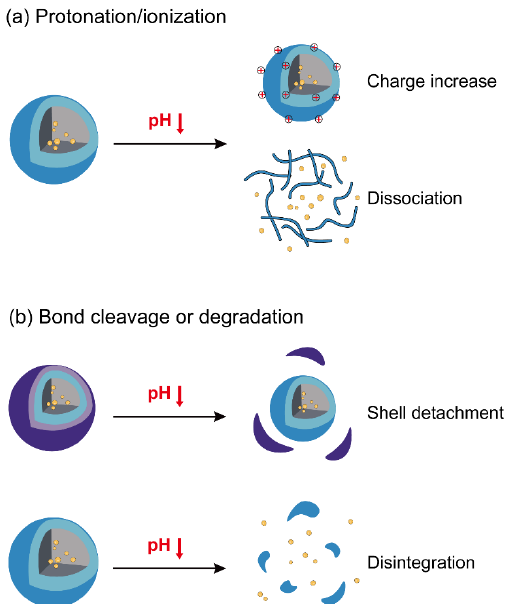
Figure 2. The typical approaches to the pH-response of nanoparticles for cancer immunotherapy. ( a ) Protonation/ionization and ( b ) cleavage of acid-labile shells or degradation of nanoparticles at acid pH enables the significant change of surface properties or the disintegration of nanoparticles.